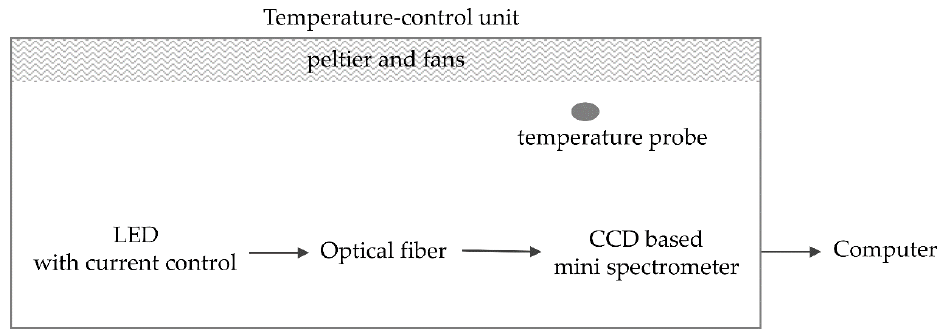
Figure 5. Experimental setup with instrumentation in the cool box for the quantification of the non-linearity of the miniature spectrometer.